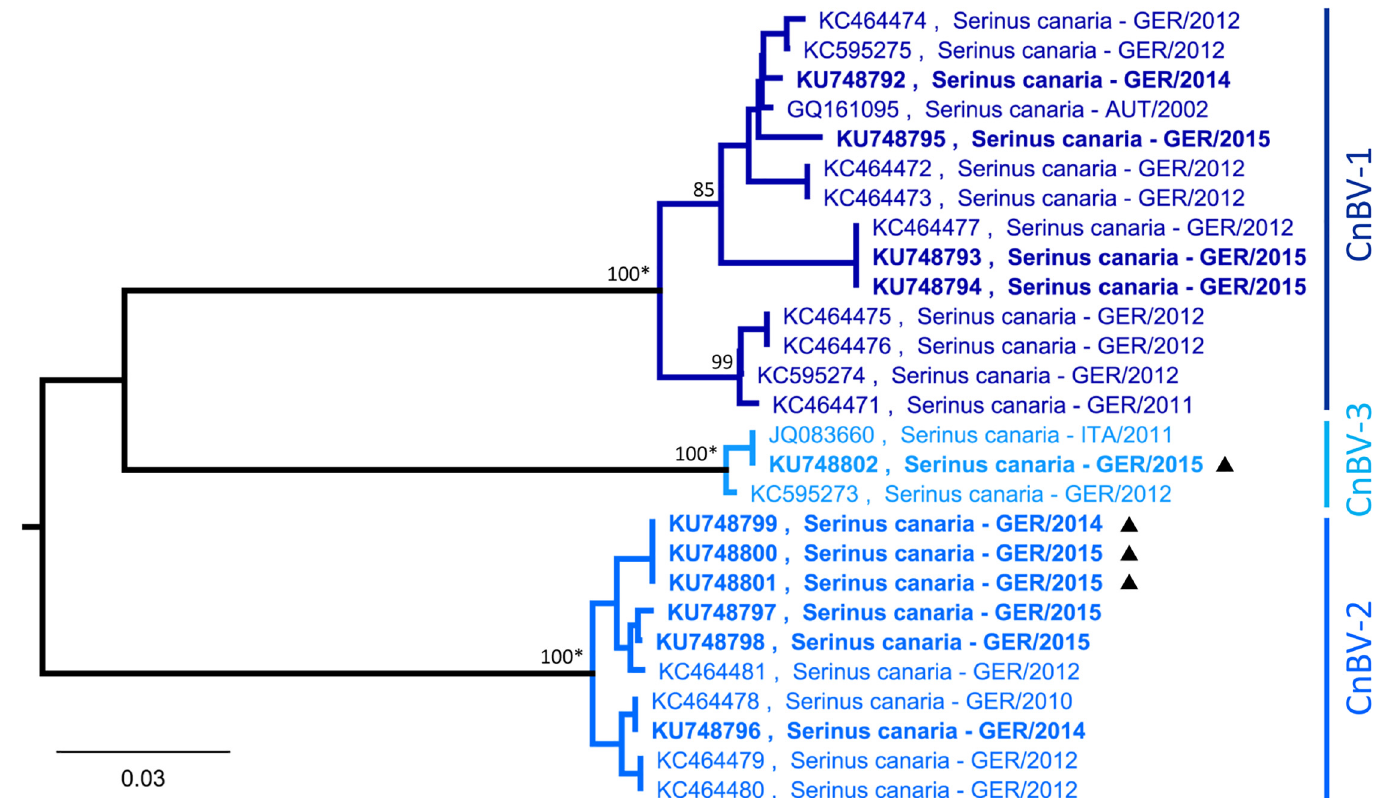
Fig 5. Clustering of CnBV-1, CnBV-2 and CnBV-3 detected in common canaries. Partial N gene sequences (343 bp) were analysed using Neighbor- Joining algorithm and Jukes-Cantor distance model in Geneious R8. The tree was rooted with Bornaviridae references sequences (not shown; see Fig 1). Values at branches represent support in 1,000 bootstrap replicates. Only bootstrap values (cid:1) 70 at major branches are shown. Nodes with bootstrap support of (cid:1) 90 in additionally performed ML analysis are indicated by asterisks. Sequences depicted in bold were generated during this study. ( ▲ ) flock E, Germany, 2014 –